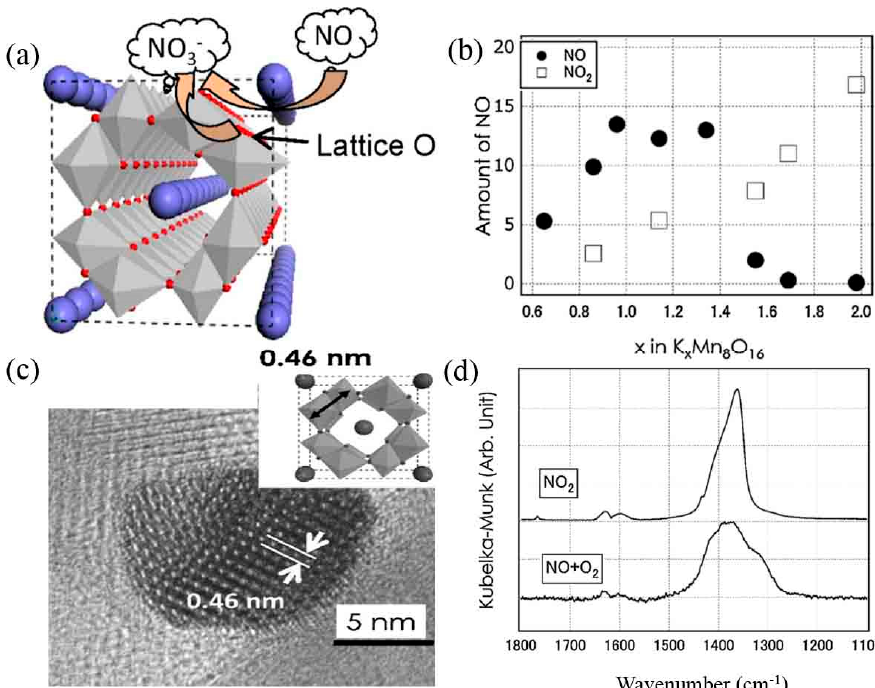
Figure 4. ( a ) Reaction mechanism of NO oxidation on OMS-2, ( b ) concentration changes of NO and NO 2 with K-doping, ( c ) morphology of OMS-2, and ( d ) Kubelka–Mung function diagram [103]. Reproduced from Ref. [103], Copyright 2016, Elsevier.